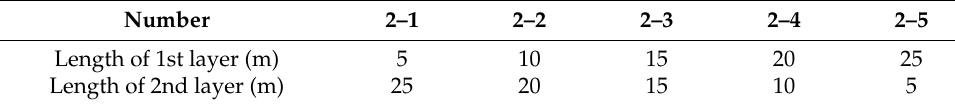
Table 2. Five types of two layers.